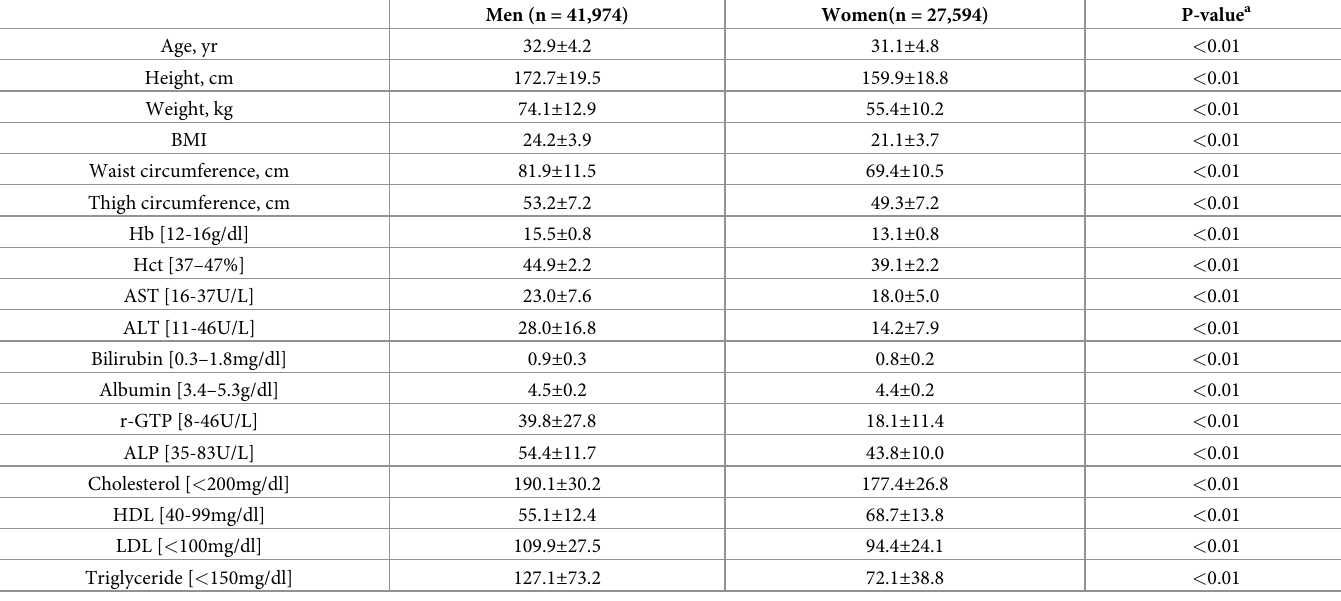
Table 1. Anthropometric indices and laboratory data of the young age group (age, 20s to